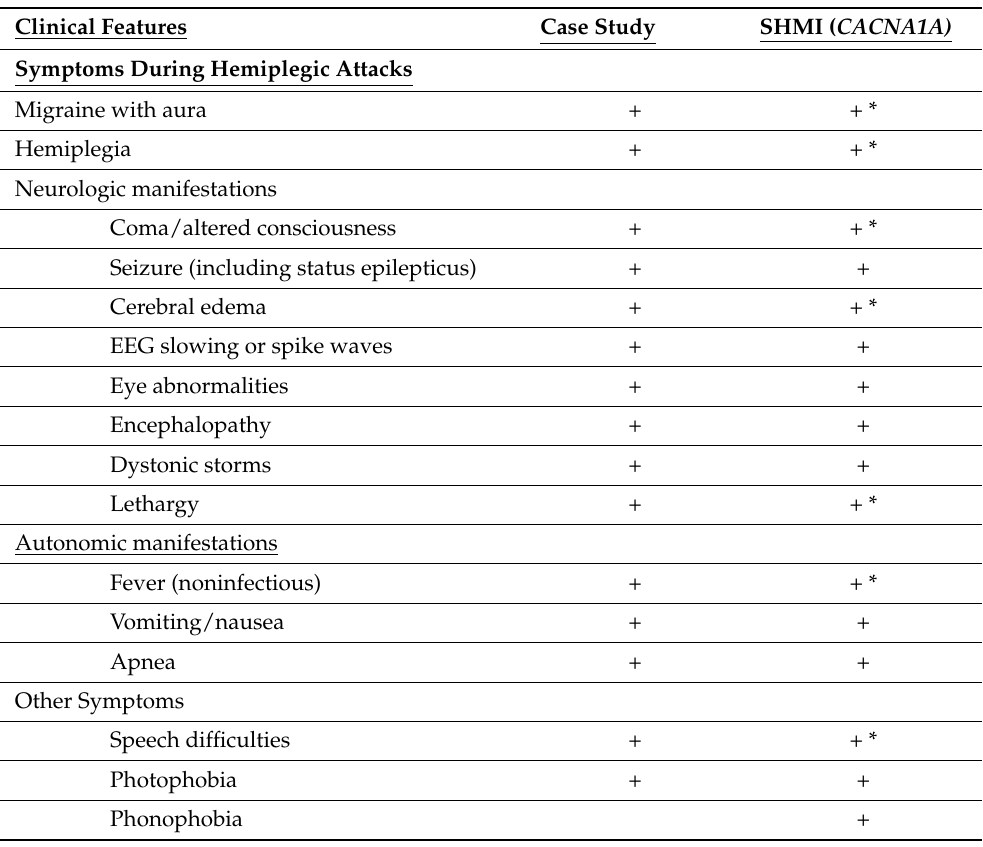
Table 5. The case study patient’s symmetry to the CACNA1A -SHM1 phenotype. (* notes common to FHM1 as well but less common were coma, cerebral edema, tremor, and